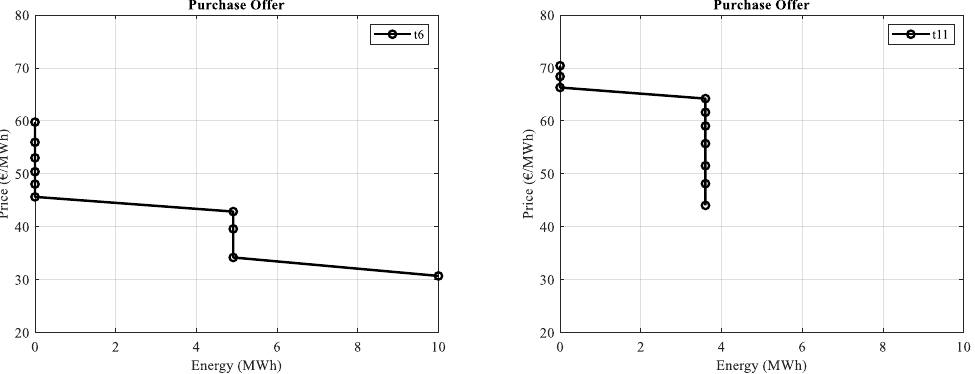
Figure 2. Purchase offering curves: left , hour 6; right , hour 11.